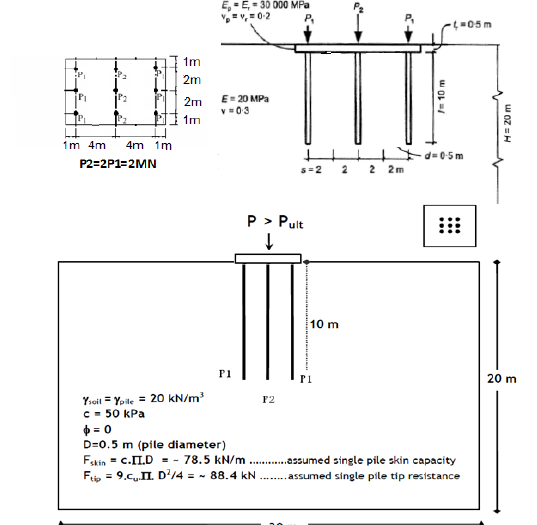
Fig. 15. Definition of hypothetical example by Poulos [1] which is used for software